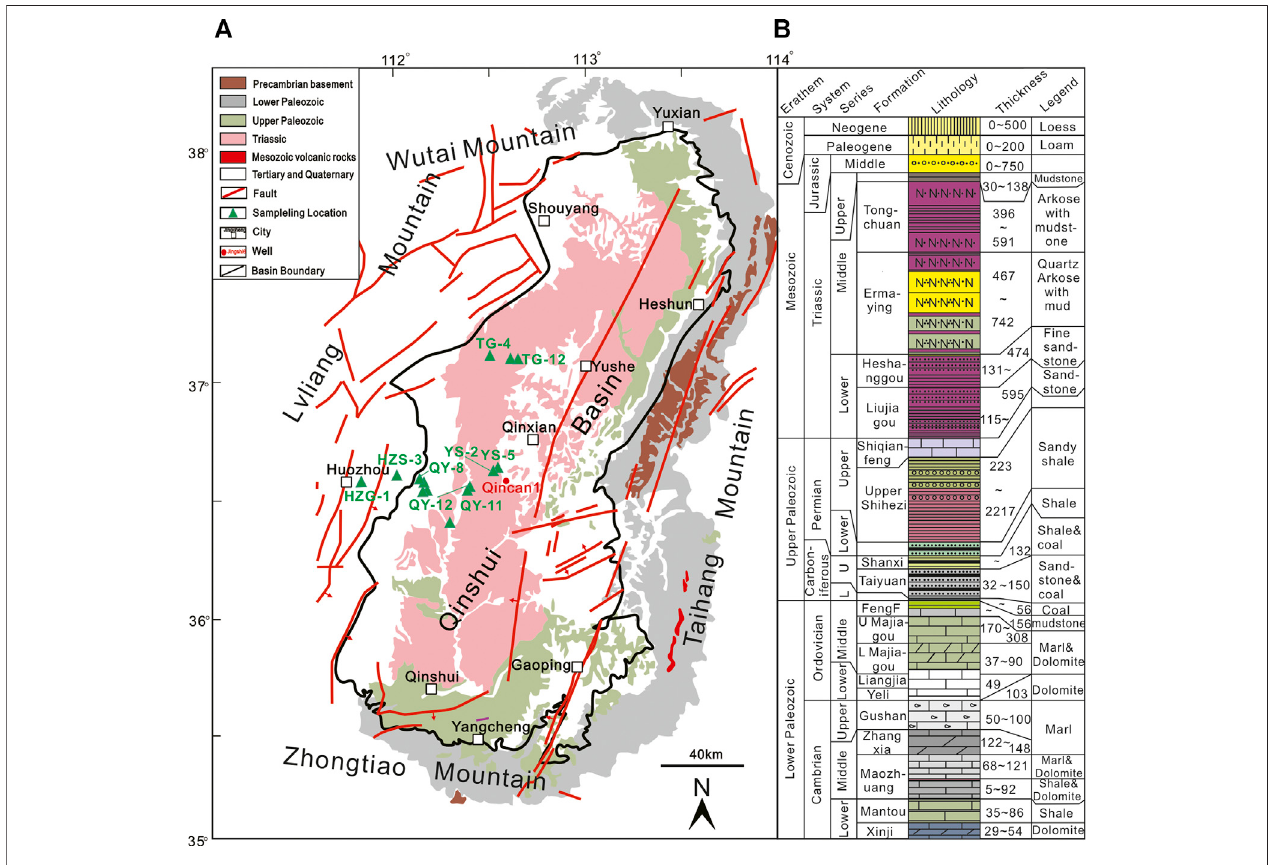
FIGURE 2 | (A) Sample location in Qinshui Basin, includes crack, well location, and city location. Structures modi fi ed from Meng et al. (2015), Zhu et al. (2014). (B) Regional stratigraphy column of the Cambrian-Cenozoic strata in the Qinshui Basin (Shanxi, 1989; Zhu, 2013; Zhu et al., 2014; Li Z. et al., 2018; Liu, 2020).